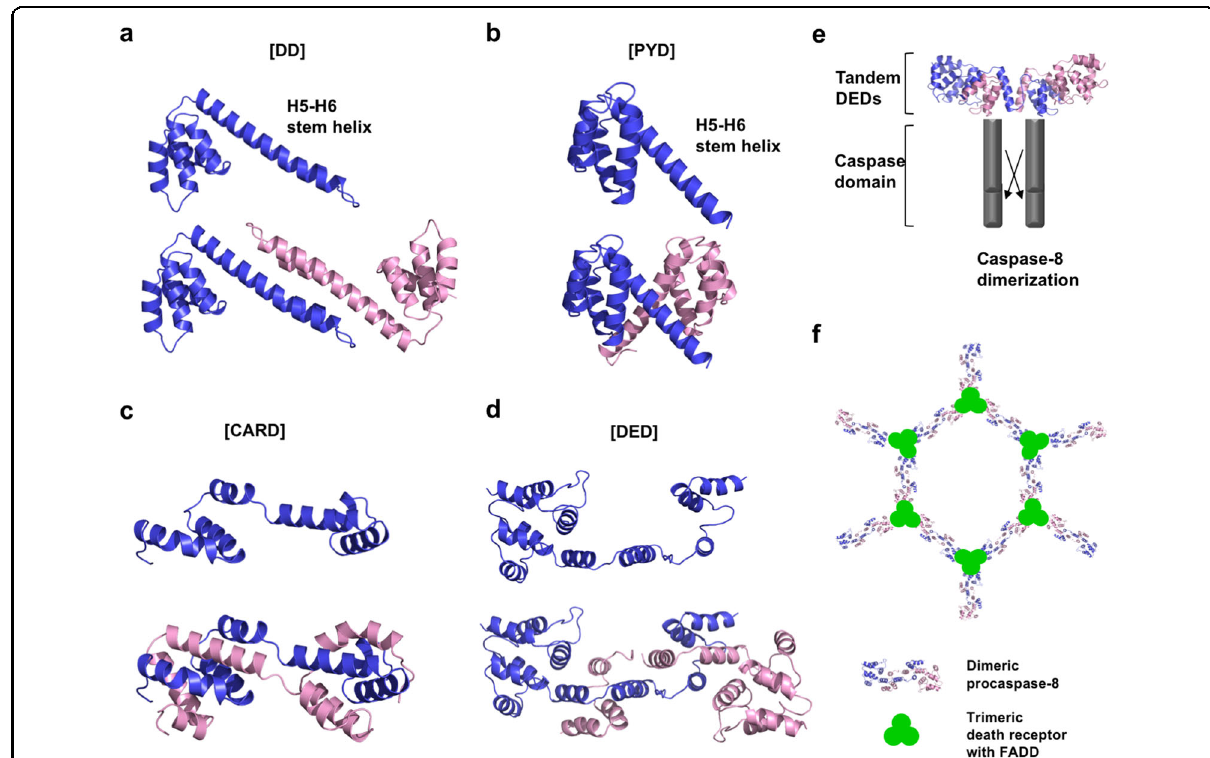
Fig. 3 Domain-swapping-mediated oligomerization in death domain (DD) superfamily members. Representative cases of a DD (Fas DD), b pyrin domain (PYD) (NLRP14), c the caspase recruitment domain (CARD) (COP from frog virus 3), and d death effector domain (DED) (caspase-8) are shown. Stem helix-mediated dimerization was observed for a DD and b PYD. The connection of H5 and H6, which serves as a dimerization stem helix, is labeled. A monomer (upper panel) and a stem loop-mediated dimer (lower panel) are shown in a cartoon. Regional domain-swapping-mediated dimerization is shown for CARD ( c ) and DED ( d ). A monomer (upper panel) and regional domain-swapping-mediated dimer (lower panel) are shown using a cartoon. e Proposed activation model of caspase-8 by domain-swapping-mediated dimerization of the caspase-8 prodomain (tandem DEDs). f Tentative model of DISC chain assembly via the interaction of the trimeric death receptor bound to the death ligand, adaptor FADD, and domain- swapping-mediated dimerized